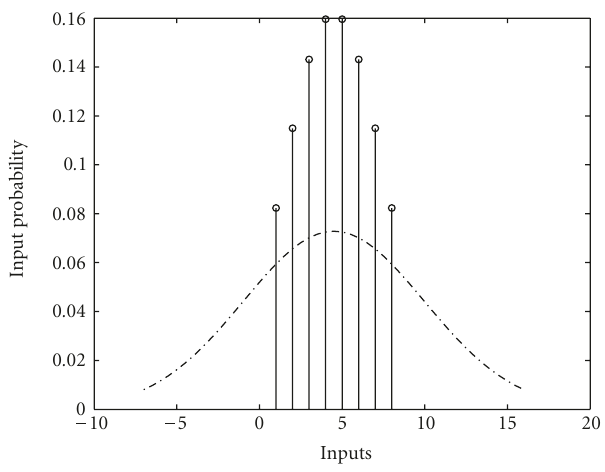
Figure 7: Maximizing input distribution at low SNR for the SISO channel.